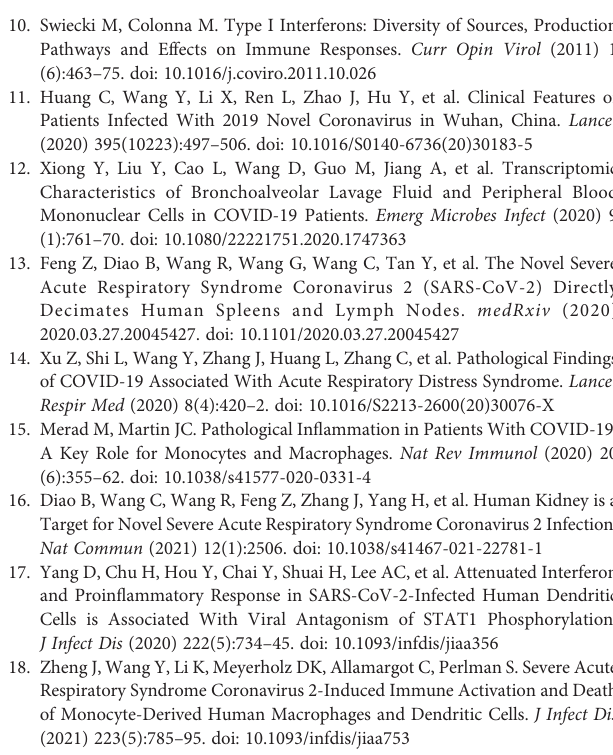
receptorACE2 (A) and phenotypicsurface markers CD14 (B) andCD16 (C) , during monocyte-macrophage differentiation was analyzed by fl ow cytometry in absence or presence of captopril. All experiments were done at least twice with representative images (n=3 donors). w/o: without. Supplementary Figure 2 | Kinetic growth of SARS-CoV-2 in human monocyte- macrophage. MOIs used for SARS-CoV-2 challenge in MDMs were 0.001, 0.01, and 0.1. Number of virus genome equivalents/ml was measured in culture supernatants by RT-qPCR on day 11 (n=4 donors). Supplementary Figure 3 | Fold changes of immune response genes in SARS- CoV-2-challenged MDMs. Heat map offold changes in the expression of 84 genes speci fi c for human innate and adaptive immune responses in SARS-CoV-2- challenged MDMs compared to mock-challenged MDMs at different time points after the infection, determined using RT2 Pro fi ler Human Innate and Adaptive Immune Response 96-well Array. Fold changes were determined via Qiagen ’ s RT2 Pro fi ler analysis software (n=4 donors). Supplementary Figure 4 | Differential proteomic analysis of SARS-CoV-2- challenged MDMs. Volcano plots showing the fold change plotted against the P value highlighting signi fi cantly changed proteins (red – upregulation and green – downregulation; p ≤ 0.05 and an absolute fold change ≥ 2) in SARS-CoV-2- challenged MDMs compared to mock-challenged MDMs at different time points (n=4 donors). Thevertical lines correspond to the absolute fold change of2, andthe horizontal line represents a p value of 0.05. Supplementary Figure 5 | Venn diagrams showing overlap in quanti fi ed genes and proteins of SARS-CoV-2-challenged MDMs. Overlapping genes between transcriptomic and proteomic data (n=4 donors) were identi fi ed at de fi ned time points after viral challenge. Supplementary Figure 6 | Correlation analyses of IFN pathway-related genes. Forallcorrelation analyses,95%con fi denceintervals wereused.Data aredisplayed as scatter plots and correlations were determined using Pearson product moment correlation coef fi cients and were adjusted for